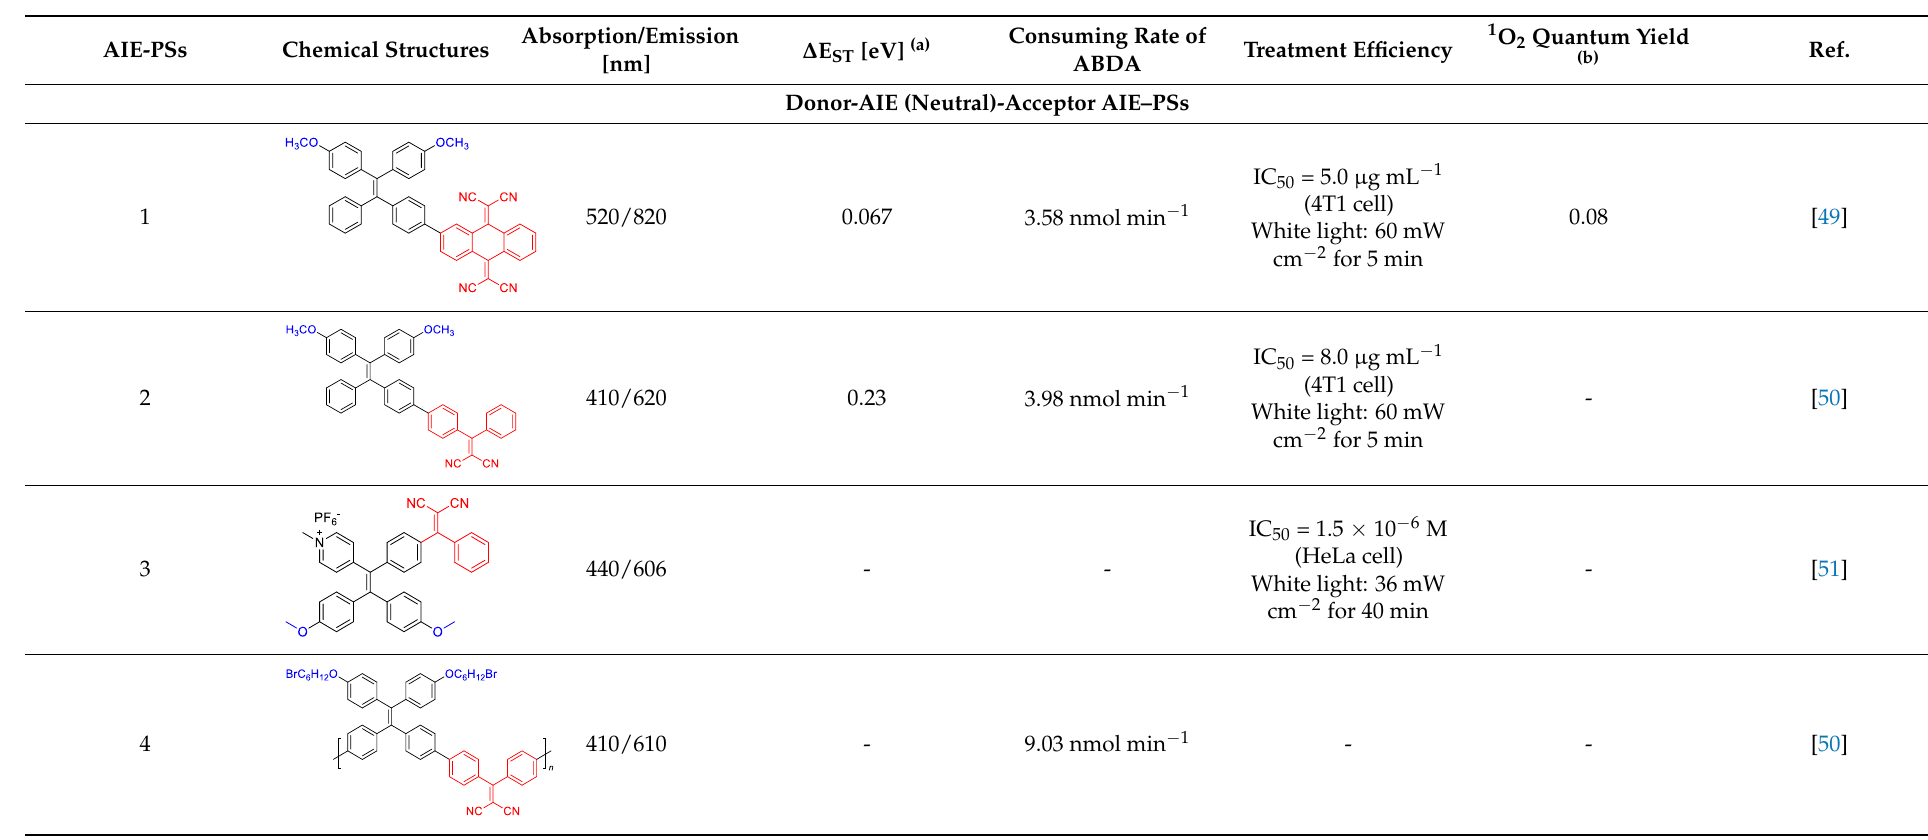
Figure 5. Classification of neutral, donor and acceptor AIE cores by their electron characters, the electronic clouds are represented by colored clouds (the neutral, donor and acceptor AIE cores are represented by the black, blue and red scheme, respectively). Table 1. Chemical structures, absorption/emission peaks, Δ E ST , consuming rate of ABDA, treatment efficiency and singlet oxygen quantum yield of different AIE – PSs (the donor and acceptor groups of different AIE – PSs are represented by the blue and red scheme, respectively).